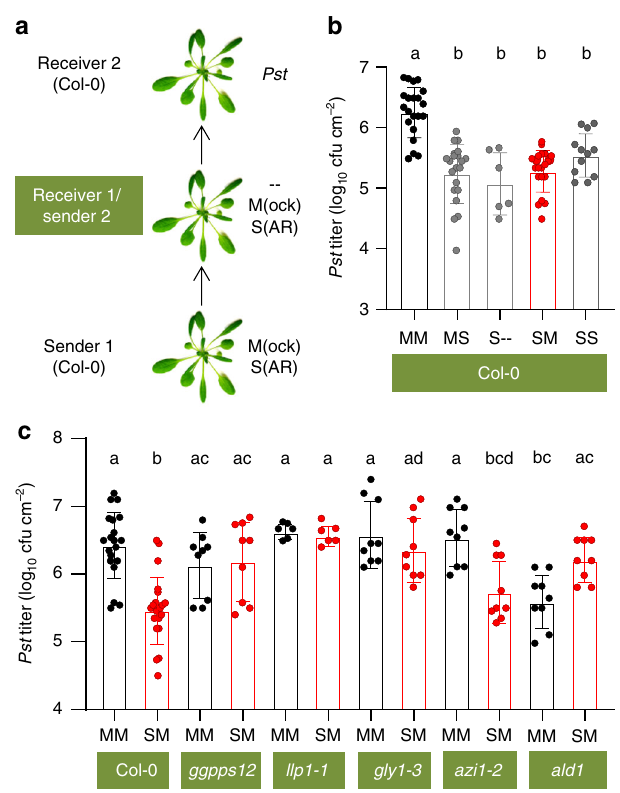
Fig. 6 PTP innate immune cues are propagated in the absence of infection and depend on monoterpene emissions and the SAR signaling network. a Plant-to-plant-to-plant (PTPTP) experimental setup. Col-0 senders (sender 1) were SAR-induced (S) or mock-treated (M) and incubated with receiver 1 plants. These plants were either not further treated ( – ), mock-treated (M) or SAR-induced (S) and incubated as secondary senders (sender 2) with Col-0 wild-type secondary receivers (receiver 2). b , c In planta Pst titers at 4dpi of receiver 2 plants. Sender 1 and receiver 2 were Col-0 wild type in all experiments; the genotypes of the receiver 1/sender 2 plants are indicated in green below the panels. Capital letters below the bars indicate the consecutive treatments of sender 1 and sender 2. Dots indicate individual results from two (S/ – in ( b ) and llp1-1 in ( c )) to three or more biologically independent experiments, including three replicates each. Bars represent the average of the indicated results ±standard deviation. Different letters above bars indicate signi fi cant differences, one-way ANOVA, P <